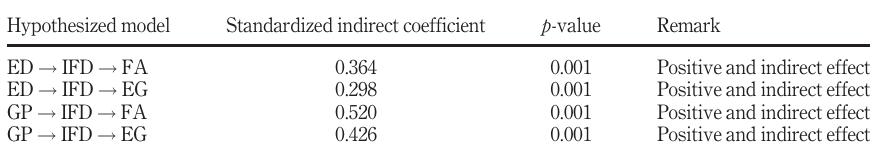
Table 3. Path model and indirect